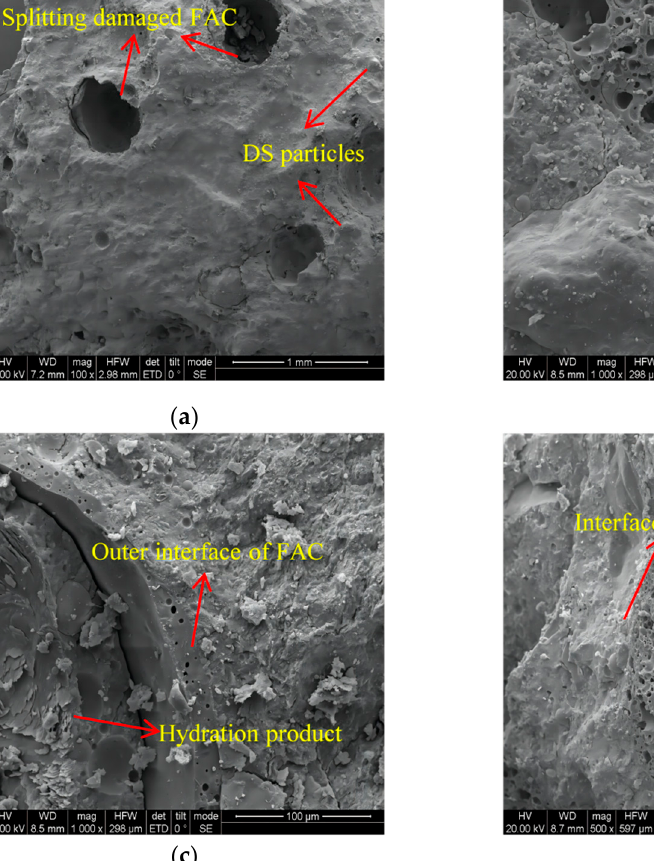
Figure 10. The SEM images of the FDCC aggregate interfaces: ( a ) a damaged specimen; ( b ) a DS interface; ( c ) an FAC interface; ( d ) a ceramsite interface.